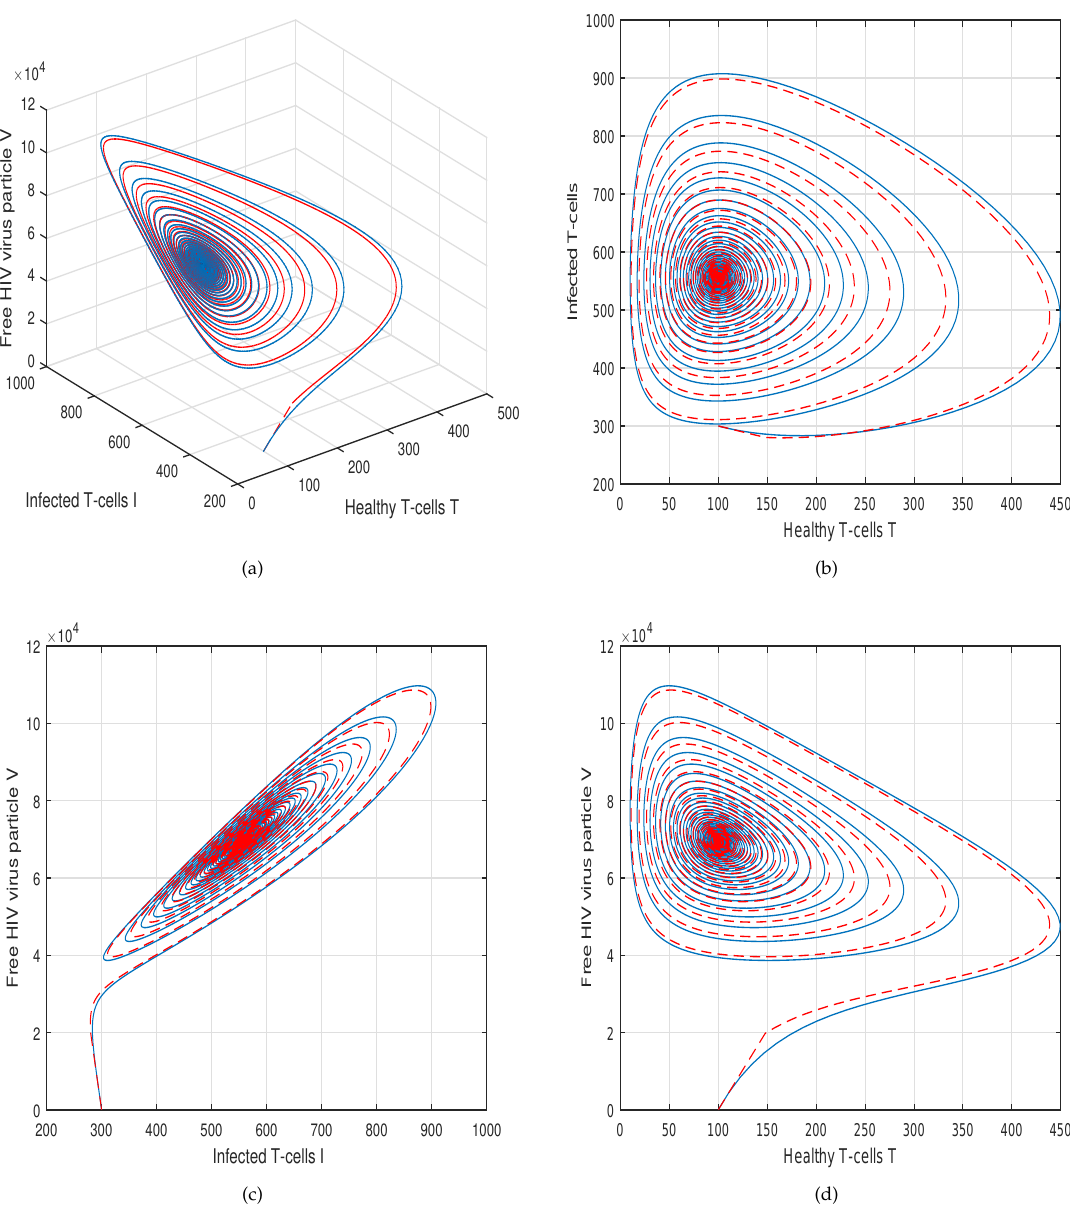
Figure 6. Illustration of the ( a ) chaotic behavior, ( b ) phase portrait of healthy CD4 + T-cells verses infected CD4 + T-cells, ( c ) phase portrait of infected CD4 + T-cells verses free HIV virus particles and ( d ) phase portrait of healthy CD4 + T-cells verses free HIV virus particles of the fractional model (2) of HIV infection with fractional-order ϑ =